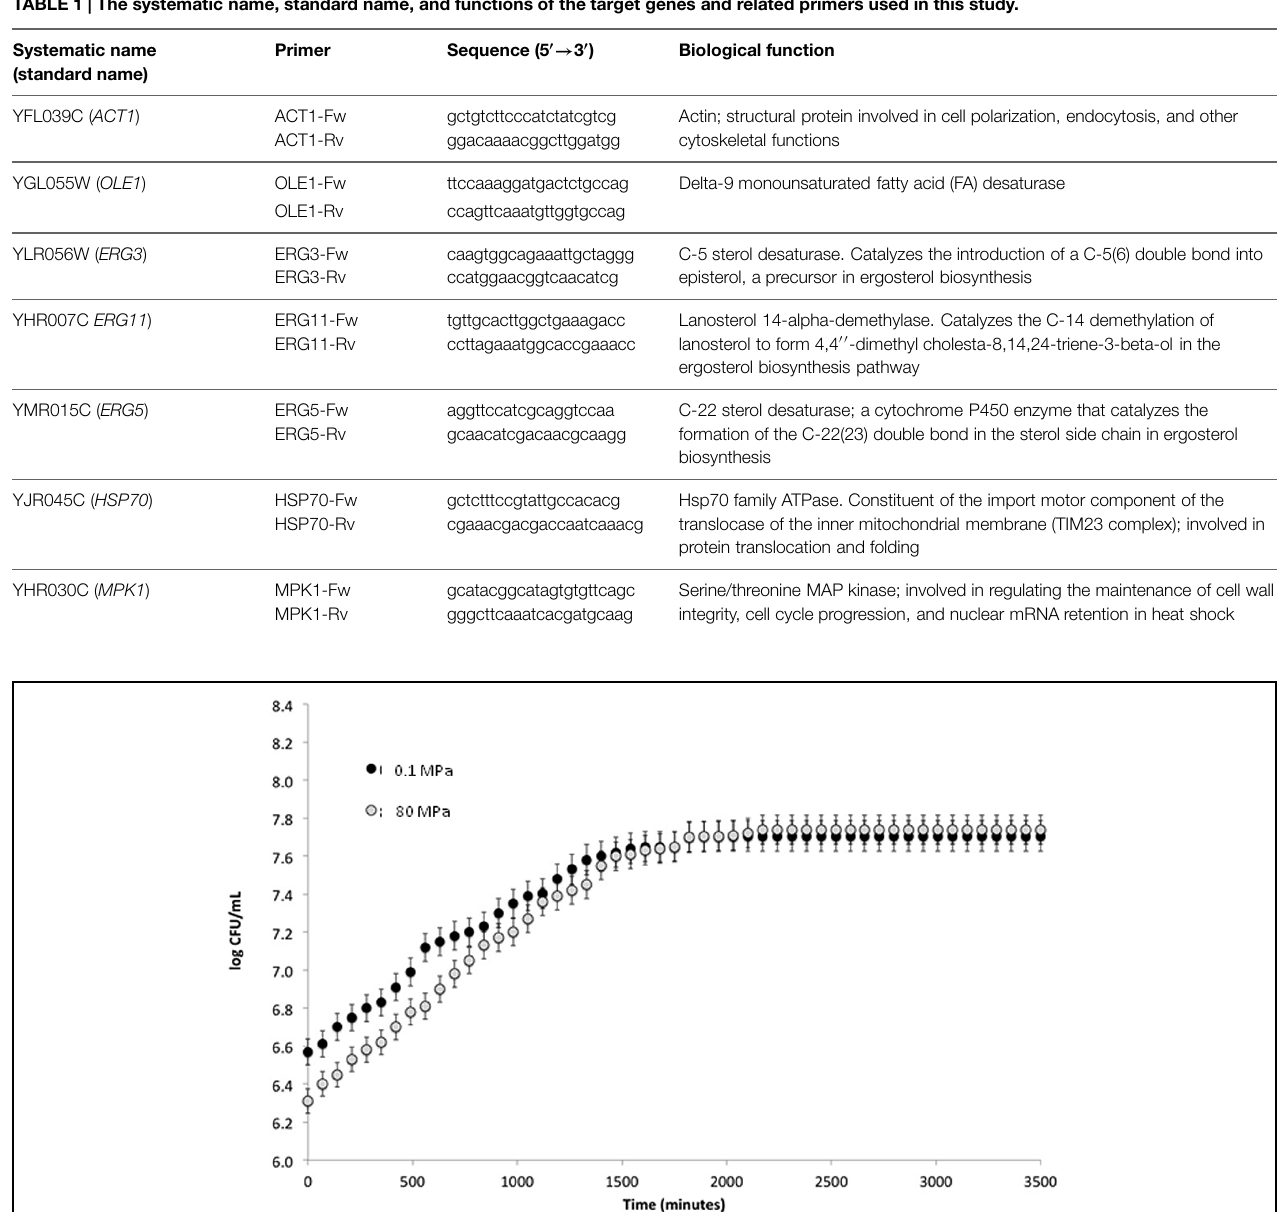
TABLE 1 | The systematic name, standard name, and functions of the target genes and related primers used in this study.